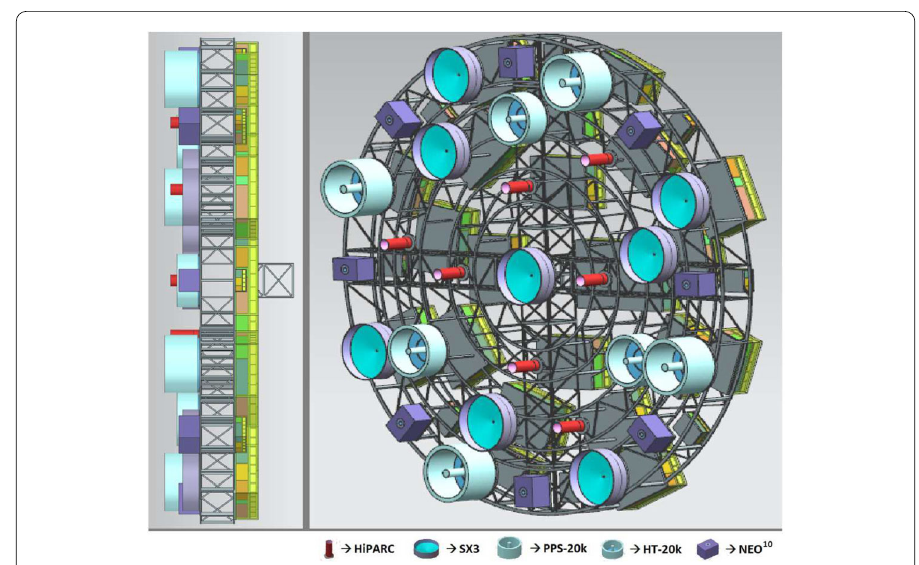
Figure 5 CAD design of gridded cluster plate including European electric thrusters with redundant PPUs for each thruster at the backside